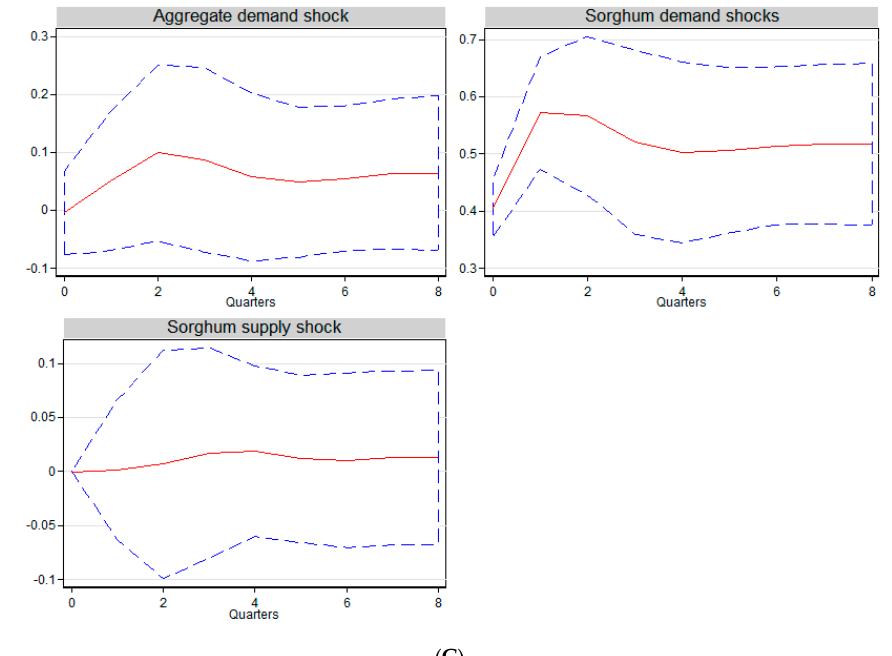
Figure 2. ( A ) Response of barley price to barley-related shocks. ( B ) Response of corn price to corn-related shocks. ( C ) Response of sorghum price to sorghum-related shocks. Notes: Red lines represent cumulative orthogonalized impulse–response functions while blue lines represent 95% confidence intervals.